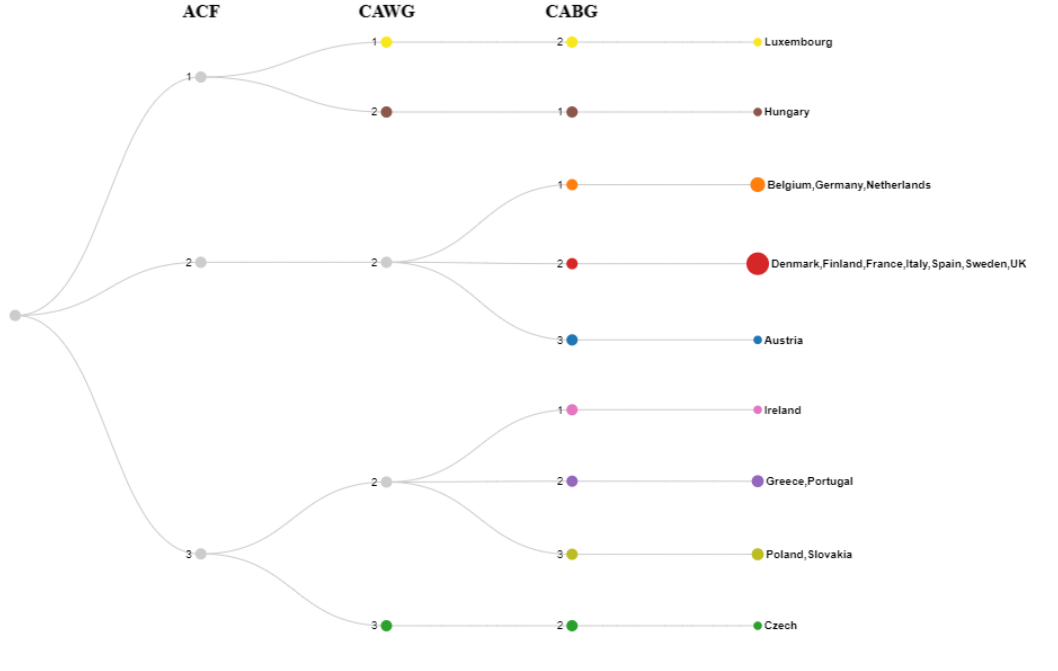
Figure 2. Classification comparison of ACF, CAWG, and CABG (in 3